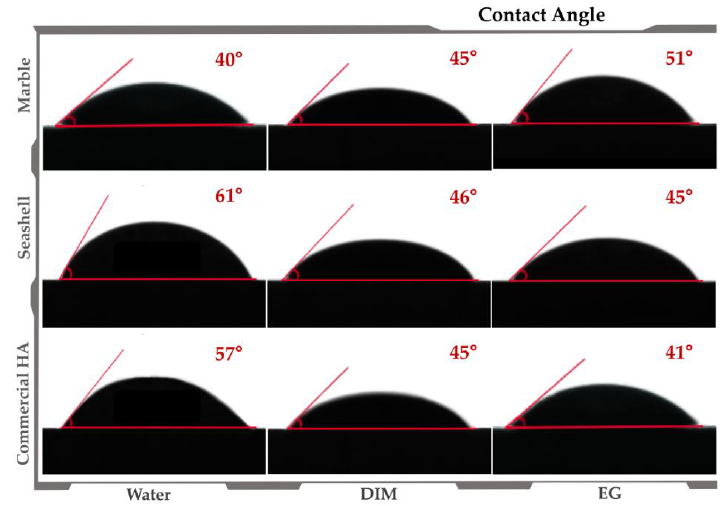
Figure 4. Contact angle assessment for marble- and seashell- derived ceramics and commercial HA samples.